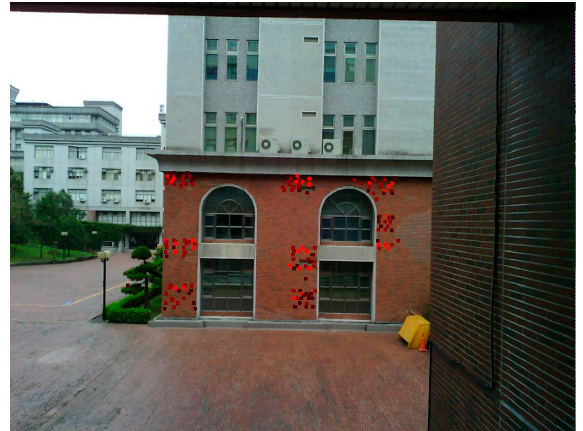
Figure 4. The defect locations identified by acoustic tracing